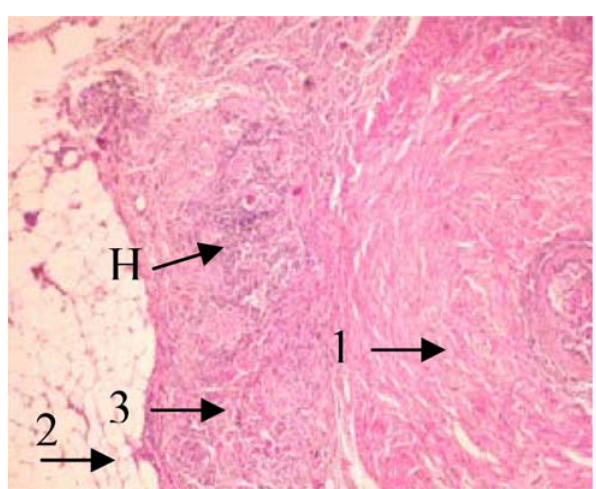
FIGURA 7 - Animal do grupo C - Cortes histológicos de fragmento de funículo espermático (1) com acentuada fibrose parietal e obstrução parcial luminar, envolto por tecido fibroadiposo (2) com vasos ectasiados e granulomas do tipo corpo estranho (H) em torno de material amorfo, fibrose e com focos de moderado a acentuado infiltrado linfoplasmocitário (3). Corado por H. E. (x40).